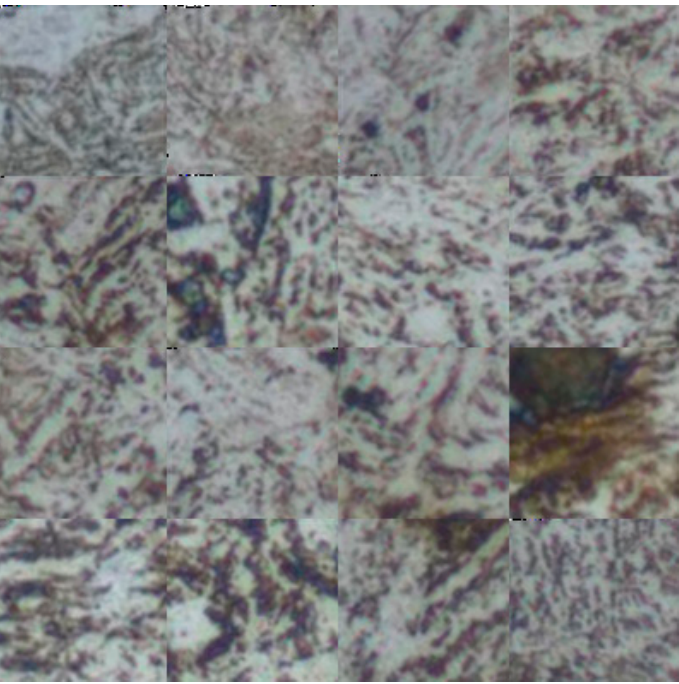
Figure 5. An example of the training image after merging with 16 images. The HV of this synthe- sized image is 359.4. image is